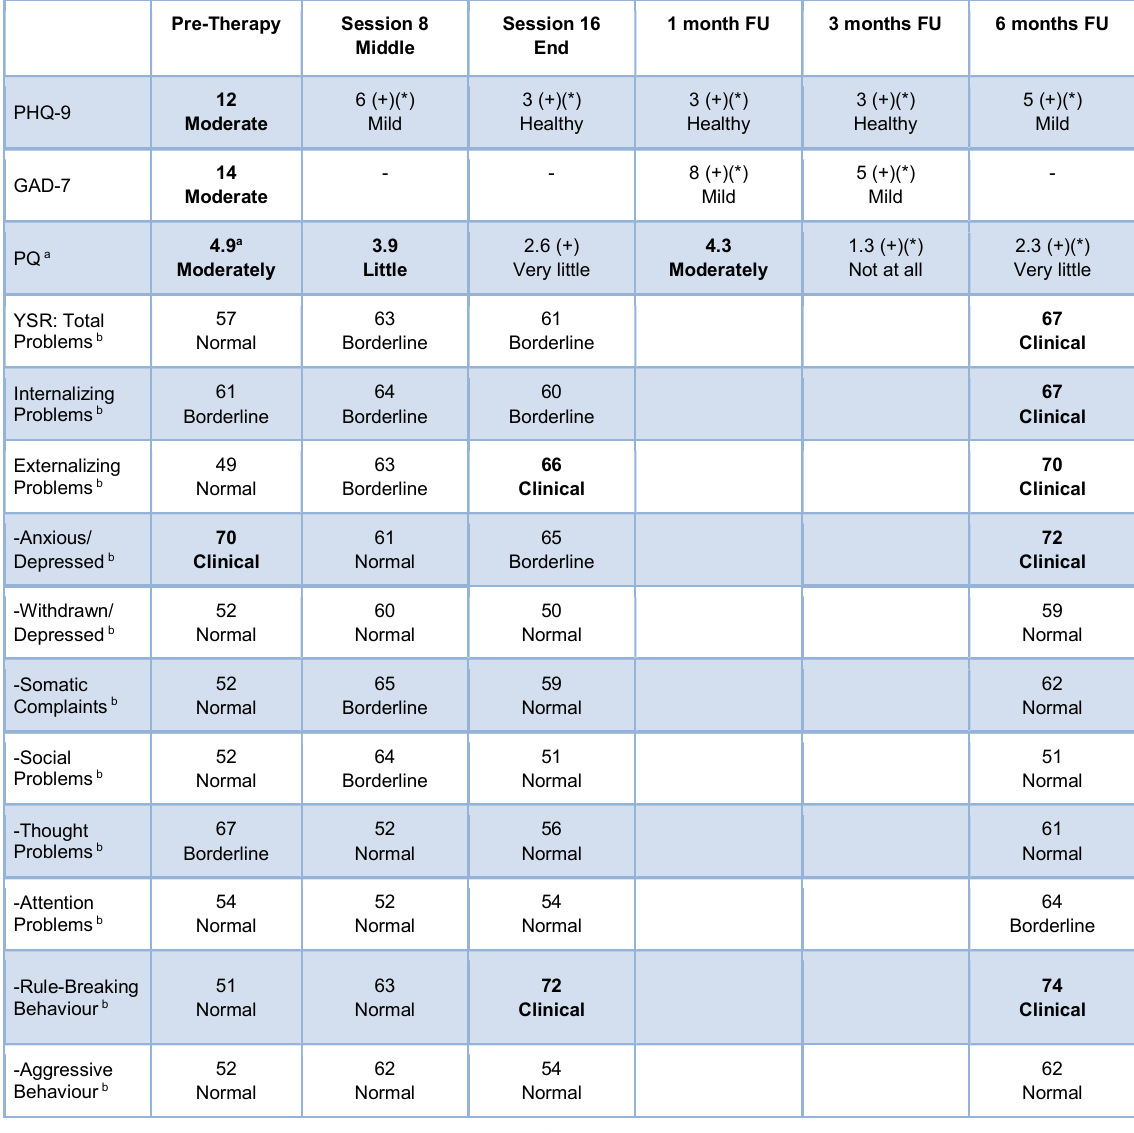
Table 1: Deborah’s Quantitative Outcome Measure Note . Values in bold are within the clinical range; + indicates clinically significant change (CS). * indicates reliable change (RC). PHQ- 9 = Patient Health Questionnaire 9-item for depression (Spitzer, Kroenke & Williams, 1999). GAD-7 = Generalized Anxiety Disorder 7- item (Spitzer, Kroenke, Williams, & Löwe, 2006). PQ = Personal Questionnaire (Elliott, Shapiro, & Mack, 1999). YSR = Youth-Self Report (Achenbach, 1991). FU =